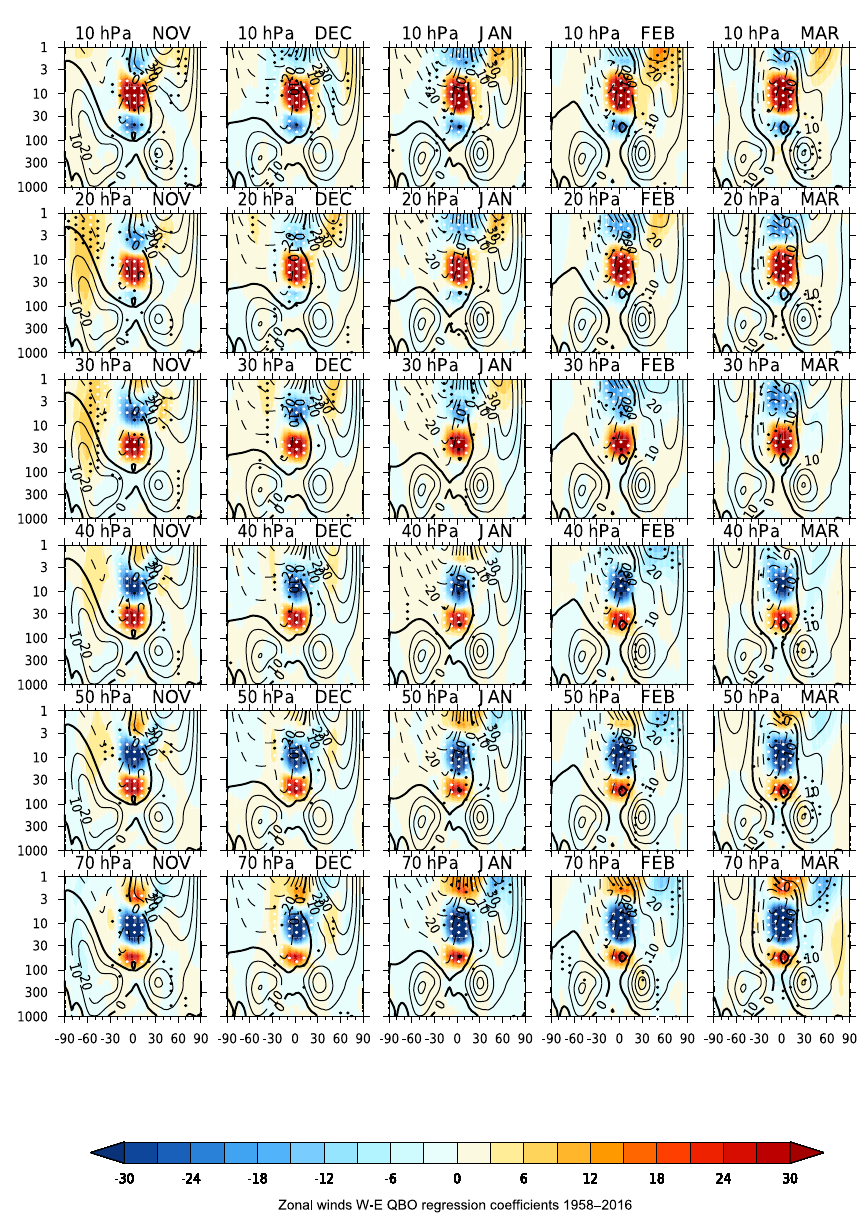
Figure 4. As Fig. 3 but with an additional index included in the regression analysis to represent the polar vortex